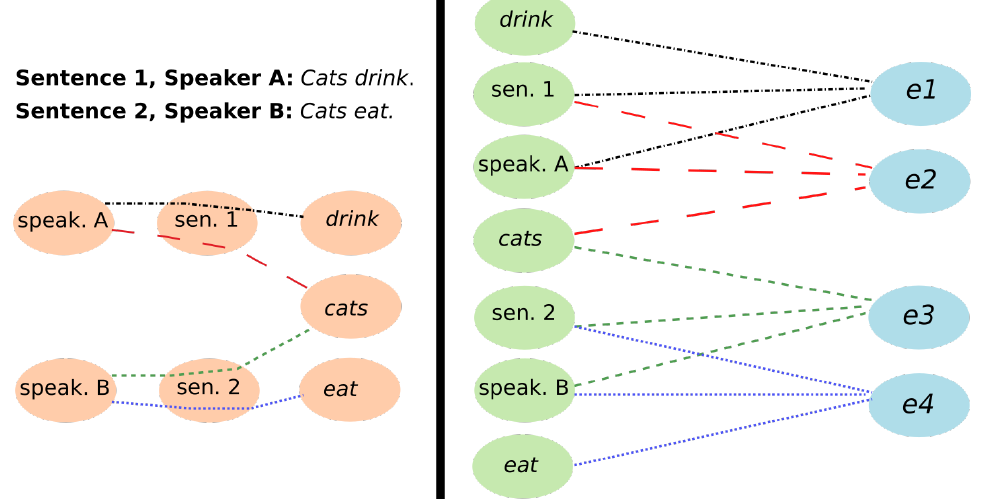
Figure 1. Sample Graph Conversion. Left Side: Sample Sentences and Corresponding Tripartite Hypergraph H ; Right Side: Corresponding Bipartite Graph B